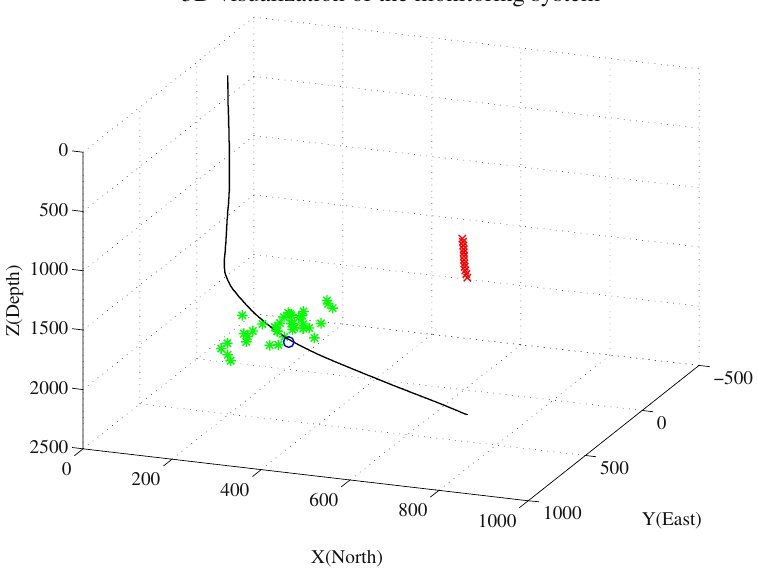
Figure 16. The results of source locating. The black curve line, blue circle and red crosses denote the trajectory of the fracturing well, the position of perforation and geophones, respectively. The green asterisks denote the inverted locations of the microseismic